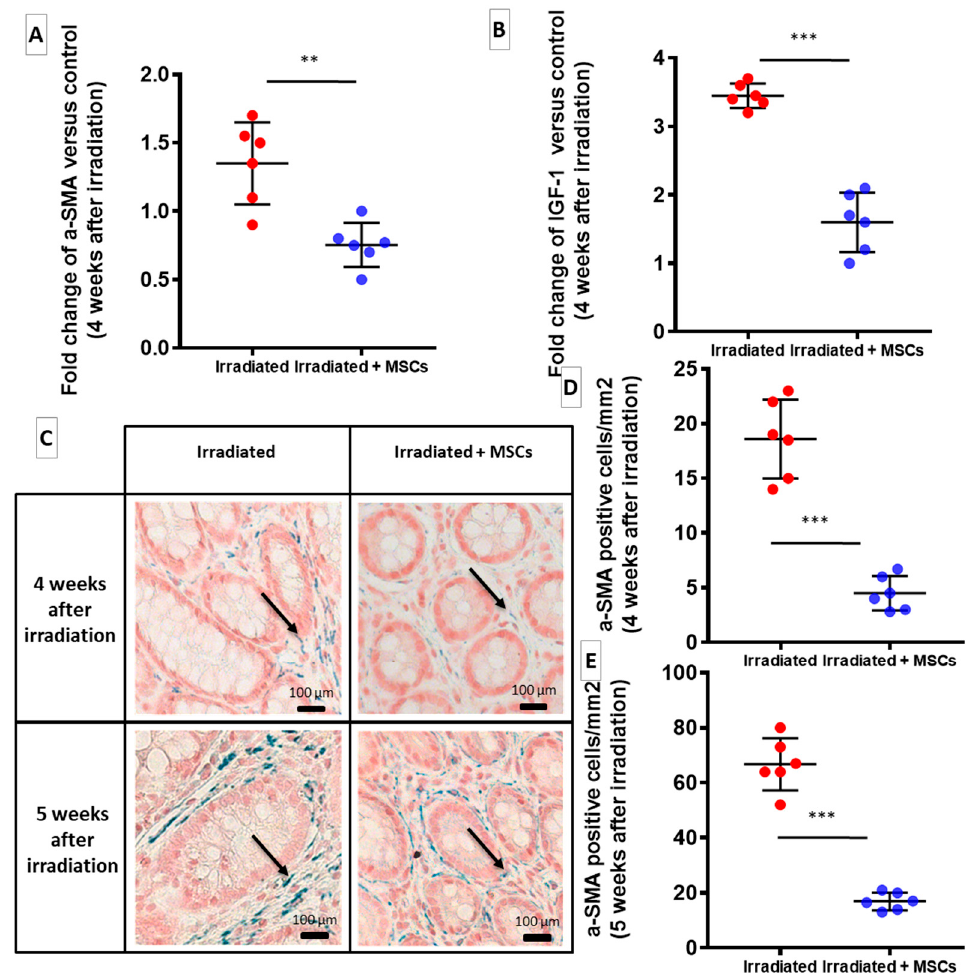
Figure 4. Involvement of myofibroblasts and SMCs in radiation-induced fibrosis and anti-fibrotic effects of MSCs. ( A , B ) mRNA fold changes of α -SMA and IGF-1, 4 weeks after irradiation and 1 week after the last MSC injection, which are normalized to Ywhaz and standardized against the Control group. ( A ) MSCs inhibit activation of α -SMA-positive myofibroblasts. ( B ) MSCs decrease expression of IGF-1, a potent activator of SMC’s pro-fibrotic phenotype. ( C ) Representative histological images of paraffin-embedded slides of colon–rectum samples stained for α -SMA (black arrows): 4 weeks and 5 weeks after irradiation (Irradiated: left; Irradiated + MSCs: right; original magnification: 100 × ). ( D , E ) Quantification of α -SMA-positive cells in mucosa of colon–rectum area of Irradiated groups with or without MSC therapy. MSCs significantly decrease number of α -SMA-positive cells in mucosa of irradiated rats 4 weeks ( D ) and 5 weeks ( E ) after irradiation. Each group of animals was composed of 6 rats. The results of each group were compared as follows: Irradiated group was compared to Control group; Irradiated + MSCs group was compared to control and Irradiated group. Two-group comparisons were performed with t -tests, while one-way ANOVAs, followed by Bonferroni t -tests, were used for multiple group comparisons. The results are expressed as mean ± SD. **: p < 0.01; ***: p ≤